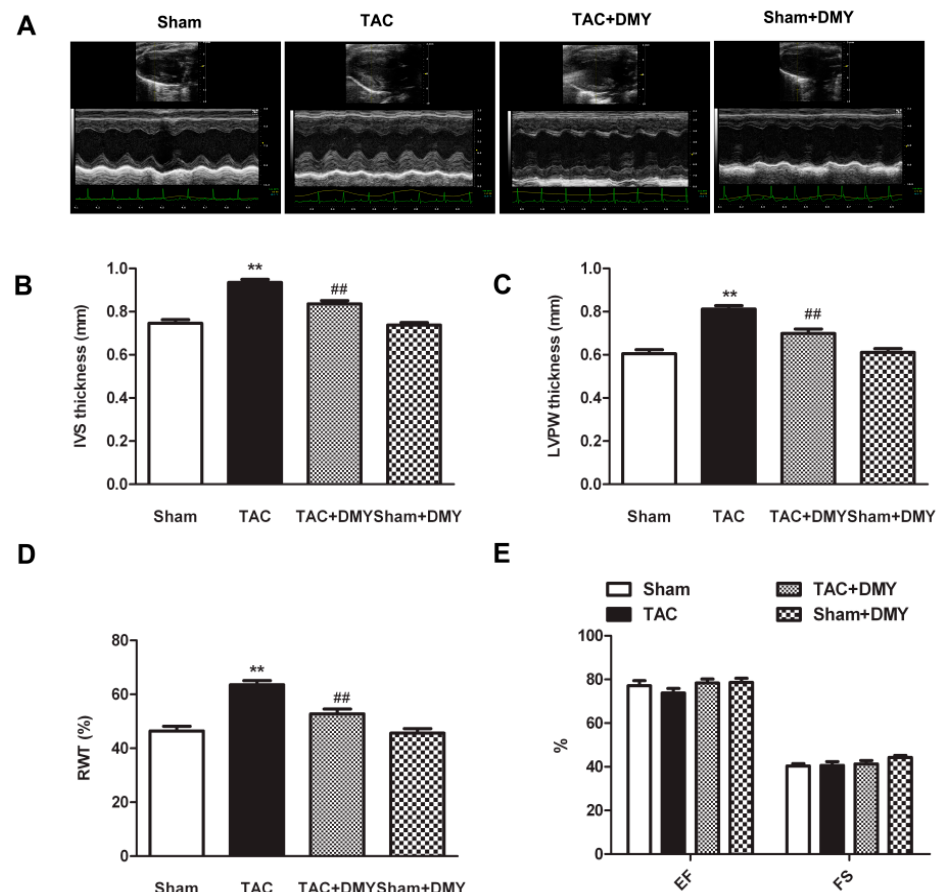
Figure 3. Effect of DMY on myocardial structure in mice after TAC. ( A ) Representative M-mode echocardiograms were shown. ( B – E ) Inter ventricular septum (IVS) thickness, left ventricular posterior wall (LVPW) thickness, relative wall thickness (RWT), ejection fraction (EF) and fraction shortening (FS) were quantified by echocardiography. ** p < 0.01 versus Sham, ## p < 0.01 versus TAC ( n =